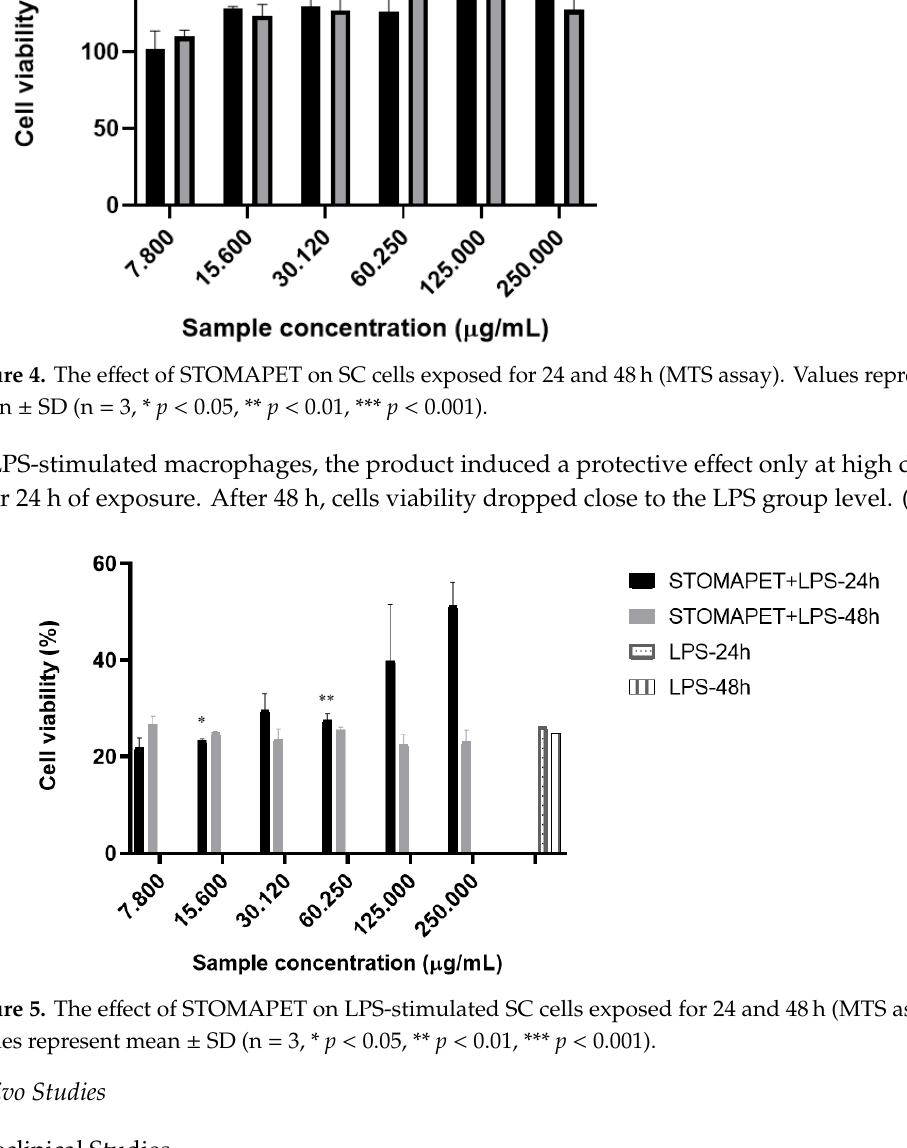
Figure 3. HPLC chromatograms of STOMAPET at 205 nm—alantolactone.